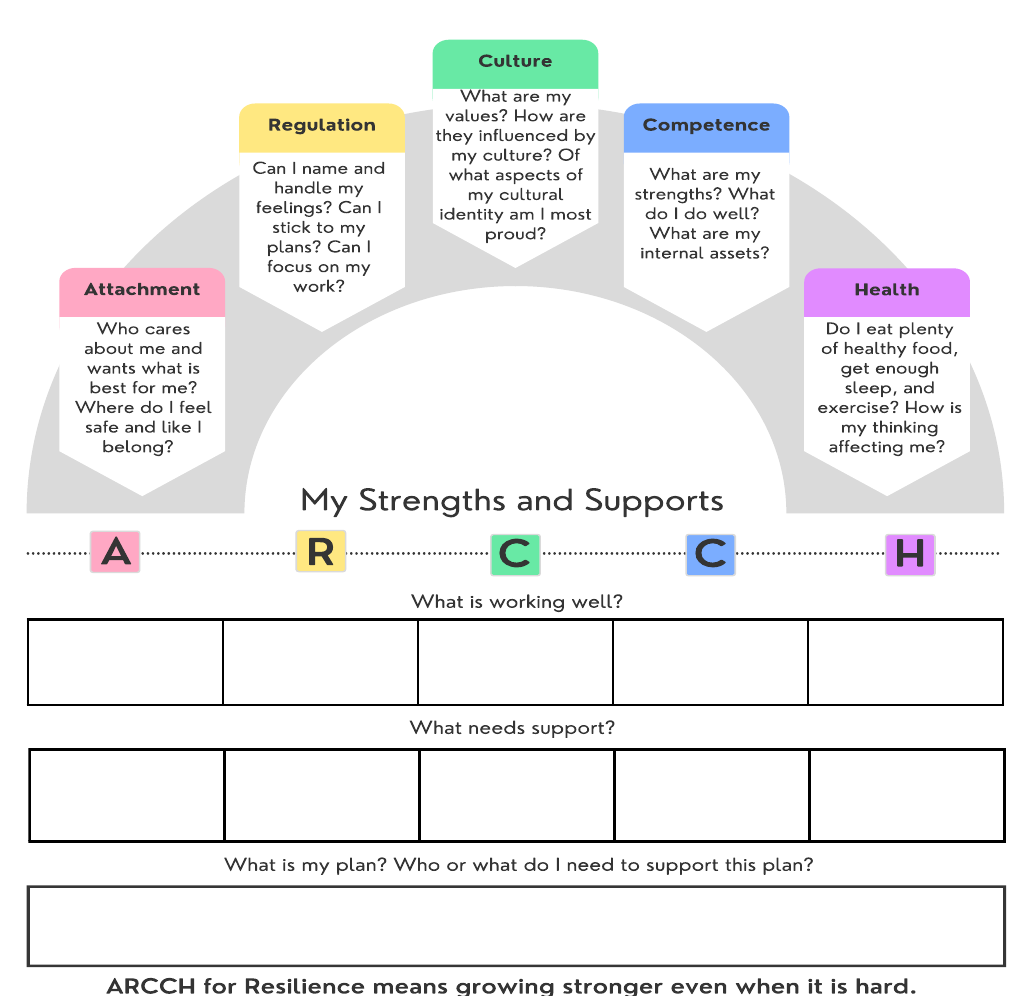
Figure A1. Worksheet to help guide ARCCH conversation with an individual.